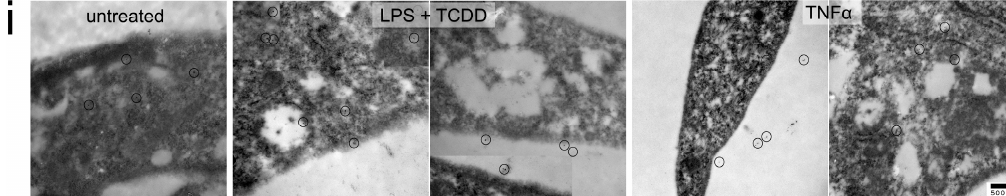
Figure 2. Activation of NLRP3 inflammasome in human ARPE-19 cells under inflammation and oxidative stress. ( a ) Confocal microscopy of ARPE-19 stimulated for 24 h with LPS (lipopolysaccharide) + TCDD (2,3,7,8-tetrachlorodibenzo- p -dioxin) and TNF α ( n = 4). Normal IgG was used as primary antibody in the negative control (NC). NLRP3 ( upper ) and caspase-1 p10 subunit ( lower ) are labeled in red . The nuclei were stained with 4’,6-diamidino-2-phenylindole dihydrochloride (DAPI) ( blue ). Image-J software is used to measure the fluorescence intensity in pixels per area in each image and expressed as fluorescence intensity ratio and shows significantly higher NLRP3 and caspase-1 levels in the stimulated cells. Scale bars = 20 µm; ( b ) Western blot analyses detect higher caspase-1 p10 subunits (10 kDa) in stressed ARPE-19 cells. ARPE-19 exposed to 4-HNE (5 µg/mL) was used as a positive control for caspase-1 mediated inflammasome activation (lane 1 ). Control ARPE-19 cells were cultured either in 10% FBS containing cell culture medium (lane 2 ) or exposed to serum-free culture medium for 24 h (lane 3 ). ARPE-19 cells were incubated in serum-free culture medium for 24 h, and subsequently treated with 10 µg/mL LPS (lane 4 ), 10 nM TCDD (lane 5 ), and 10 ng/mL TNF α (lane 6 ). To induce inflammasome activation ARPE-19 cells were pretreated with 10 µg/mL LPS and exposed to 10 nM TCDD (lane 7 ) or 10 ng/mL TNF α (lane 8 ); ( c – e ) qRT-PCR analysis of NLRP3 , pro- IL-1 β and pro- IL-18 mRNA demonstrates significantly higher levels in ARPE-19 cells stimulated with LPS + TCDD and TNF α ( n = 4); ( f ) ELISA analysis of IL-18 measures significant increases in the supernatants of ARPE-19 cells treated with LPS + TCDD and TNF α ( n = 4); ( g ) Ca 2+ mobilization analysis discloses significantly higher cytosolic Ca 2+ in ARPE-19 cells stimulated with LPS + TCDD and TNF α ( n = 4); ( h ) Ultrastructural evaluation of ARPE-19 cells stimulated with LPS + TCDD and TNF α . Normal mitochondria ( yellow asterisks) with distinctive membranes and cristae are seen in the untreated ARPE-19 cells ( left panel). Damaged mitochondria show swelling, disarrangement/loss of cristae, and only outer membranes are visible ( yellow arrows, middle and right panels). Some transitional stages from degenerative mitochondria to autophagosomes are also illustrated (arrowheads). Single-membrane autophagosomes (A) and multilayer-membrane autophagosomes are identified ( red circles with red arrows indicating membranous structure, middle and right panels). The blue arrows point formation of a plasma-membrane pore with two opening edges. N, nucleus; A, autophagosome and autophagosome-like structure; V, vesicle. Scale bar = 500 nm; ( i ) Ultrastructural evaluation of ARPE-19 cells stimulated with LPS + TCDD and TNF α following immunolabeled for NLRP3, visualized with 15-nm gold-conjugated protein. Circles indicate NLRP3 immunolabeling positive dots that illustrate extracellular translocation. Scale bar = 500 nm. Data in ( a ) and ( c – g ) are presented as mean ± SEM. * p < 0.05; ** p < 0.01; *** p < 0.001; **** p < 0.0001.